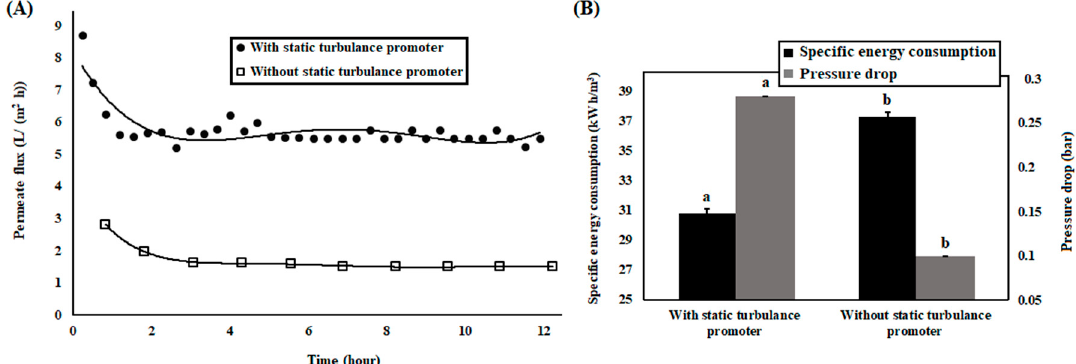
Figure 4. Membrane permeate flux with process time in absence and presence of static turbulence promoter ( A ), specific energy consumption and pressure drop in membrane separation process due to absence and presence of static turbulence promoter ( B ).